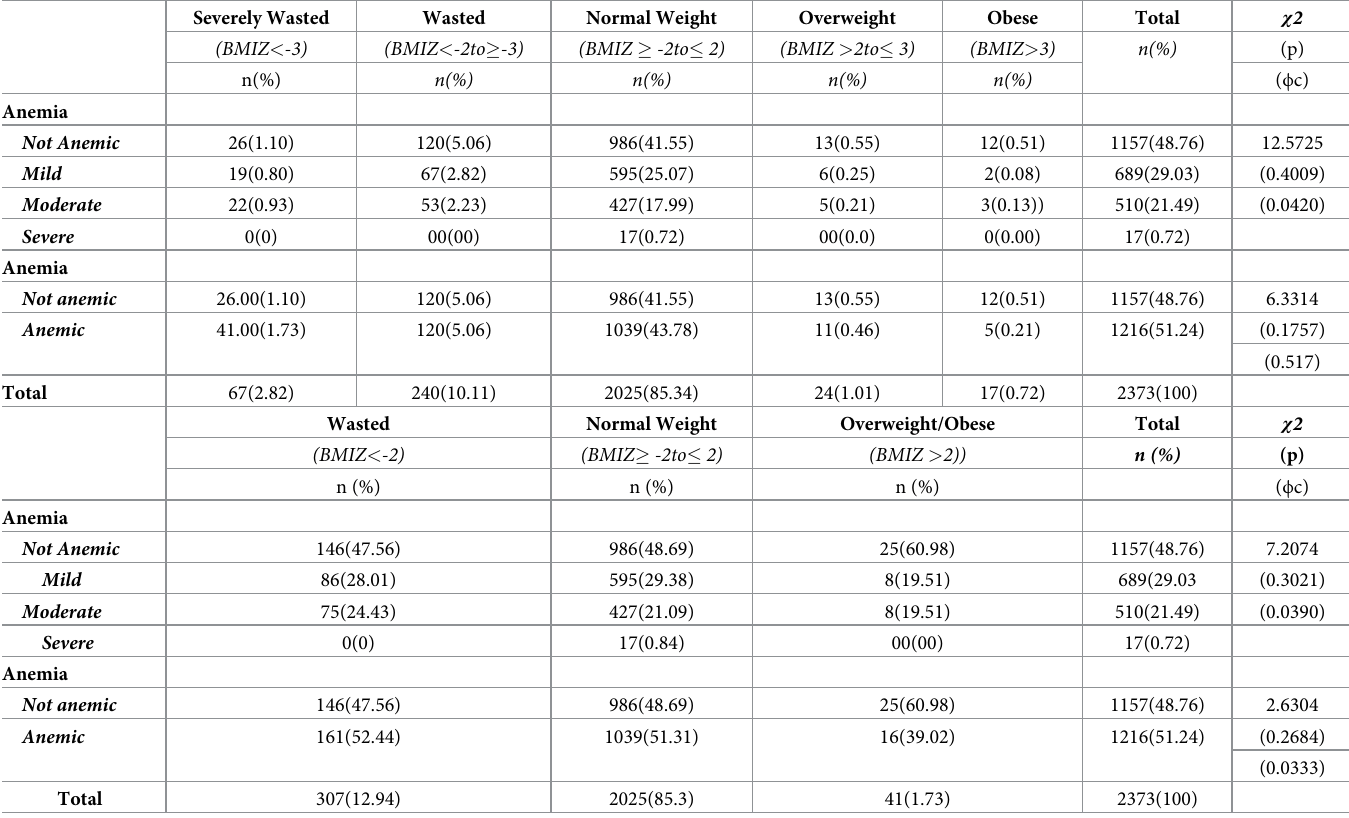
Table 2. Prevalence of anemia among children (n = 2373) based on BMI SD score category. Severely